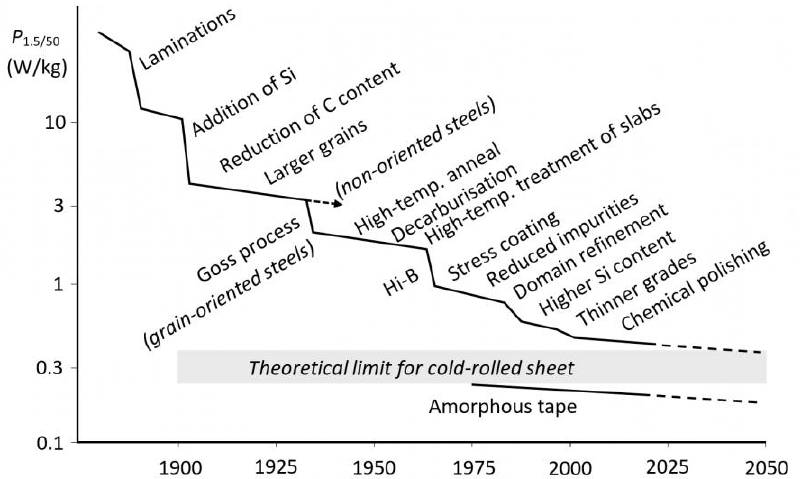
Figure 2. Reduction of specific power density due to improvements in GO processing technology.